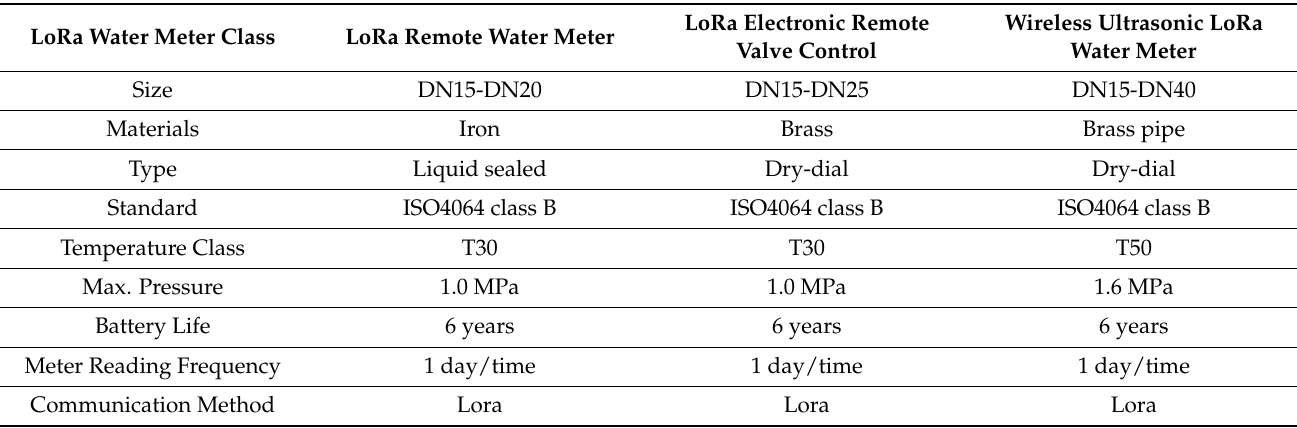
Figure 7. Samples of AMR water meters with LoRa communication technology ( a ) LoRa remote water meter; ( b ) electronic remote valve control water meter; ( c ) wireless ultrasonic LoRa water meter [59]. Table 2. LoRa AMR water meters’ specifications.